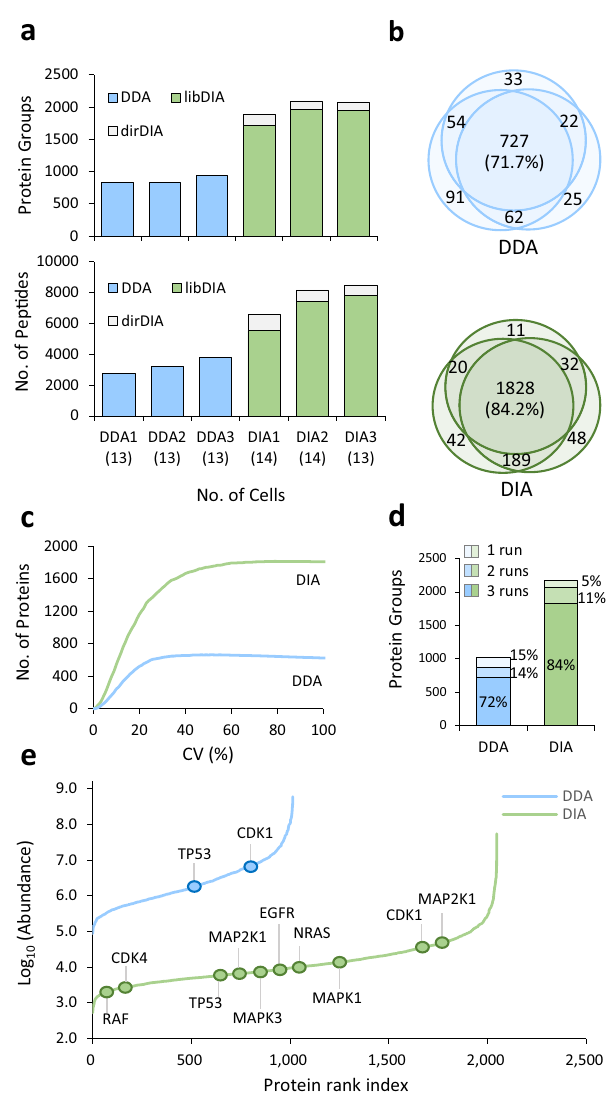
Fig. 3 Comparison of identi fi cation coverage and quantitation performance of proteomic pro fi ling of PC-9 cells by DIA and DDA methods. a Comparison of protein groups and peptides identi fi ed by triplicate analysis using the data-dependent acquisition (DDA, light blue) and data-independent acquisition (DIA, light green) modes. Single-shot DIA was acquired and processed by both library-based DIA (libDIA) and direct DIA (dirDIA) approaches by Spectronaut. b Overlap of protein groups identi fi ed by DDA and DIA. c Distribution of coef fi cient of variation (CV%) for quanti fi ed protein groups by DDA and DIA. d Evaluation of missing values (%) of proteins identi fi ed and quanti fi ed in triplicate LC – MS/MS runs by DDA and DIA. e Assessment of dynamic range based on protein abundance rank and annotation of selected proteins related to lung cancer. Source data are provided as a Source data fi